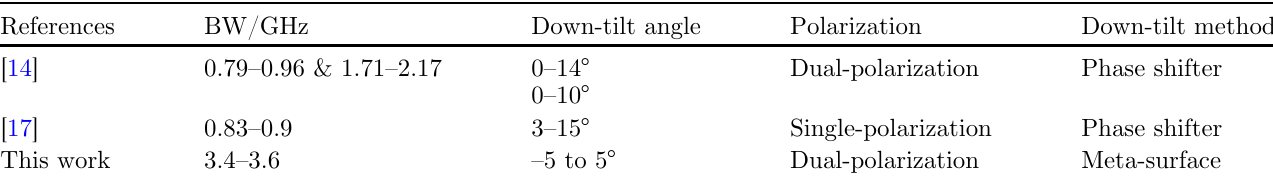
Fig. 10. (a) Fabricated compared BSAA, (b) fabricated BSAA with PRS, (c) measured and simulated S11 of the BSAA, (d) measured normalized down-tilt pattern of the BSAA at 0 ° and± 5 ° . Table 1. Comparison of proposed antenna array for base